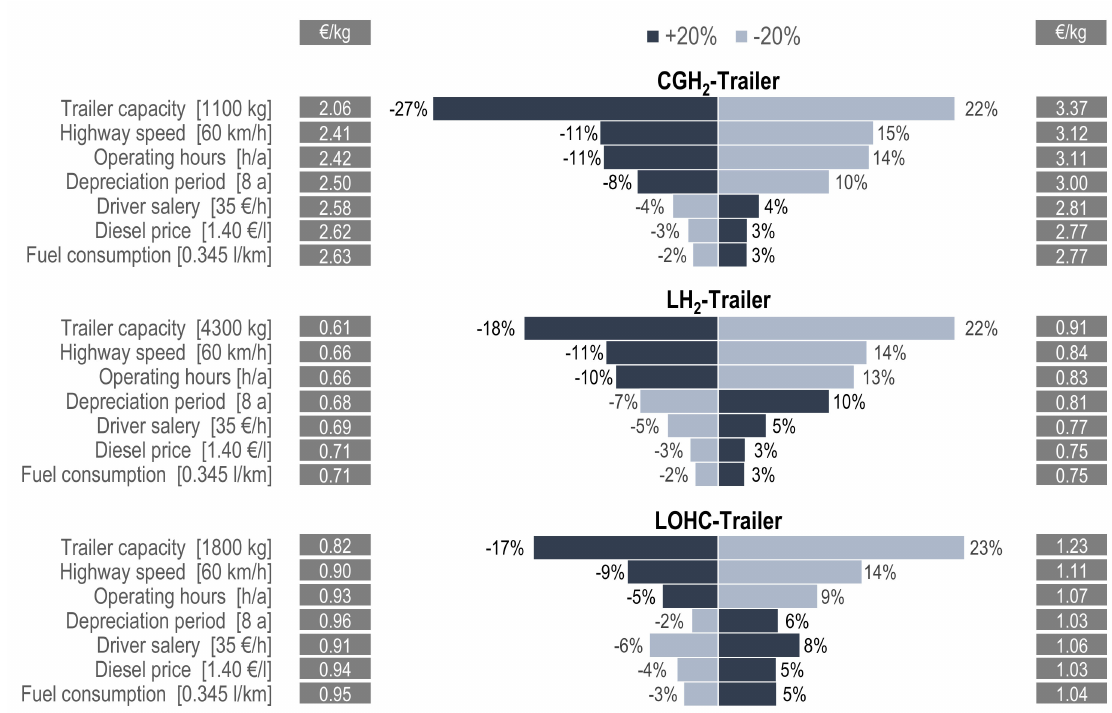
Figure 8. Variables and their impact on hydrogen transportation costs during a sensitivity analysis of ± 20%; the original values of the parameters are taken from Tables